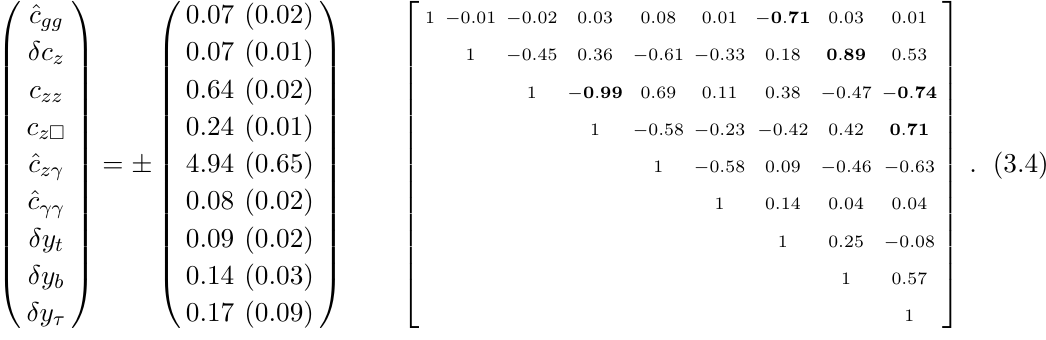
The numbers listed in parentheses correspond to the 1 (cid:27) uncertainties obtained by consid- ering only one parameter at a time, i.e. by setting to zero the coe(cid:14)cients of all the other e(cid:11)ective operators.